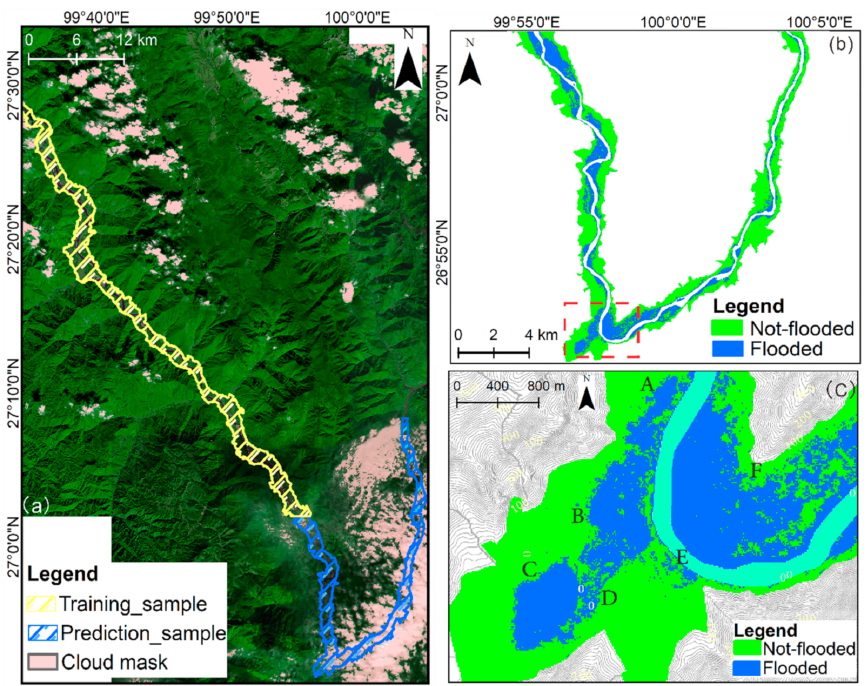
Figure 10. RF algorithm flood mapping result. ( a ) Spatial distribution of training samples and prediction samples, the cloud occlusion area C4 (Shigu Town, NO. 42); ( b ) Flood prediction results. ( c ) The detailed mapping results of the red